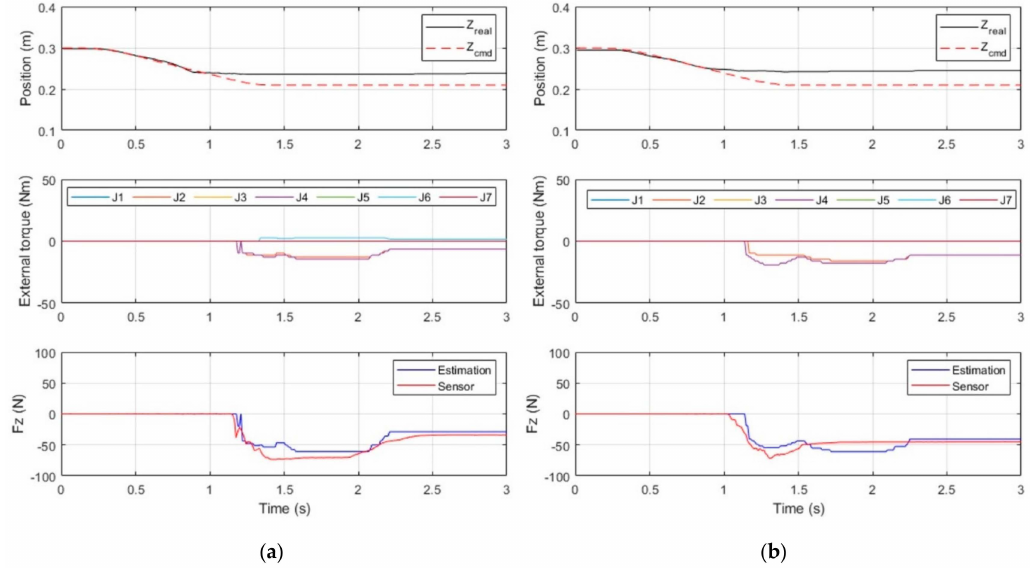
Figure 16. Results of the contact force control experiment: desired forces of 30 N ( a ) and 50 N ( b